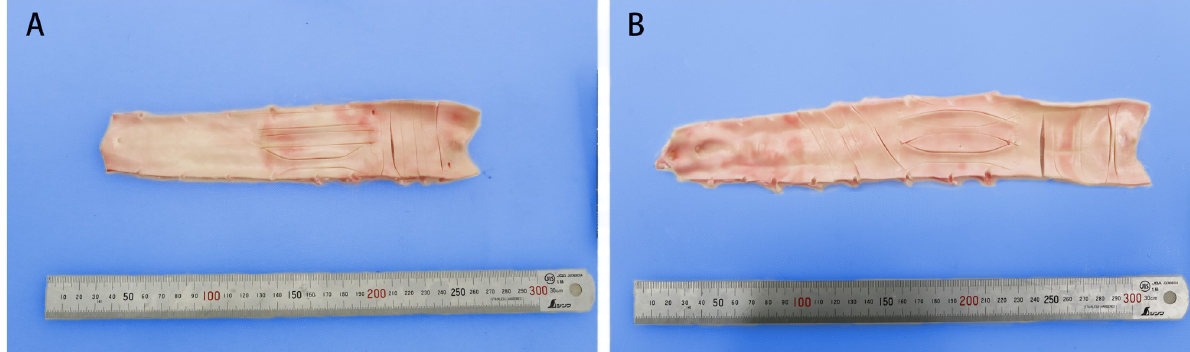
Fig 1. Distribution of specimens: (A) rectangular specimens and (B) dog-bone-shaped specimens.